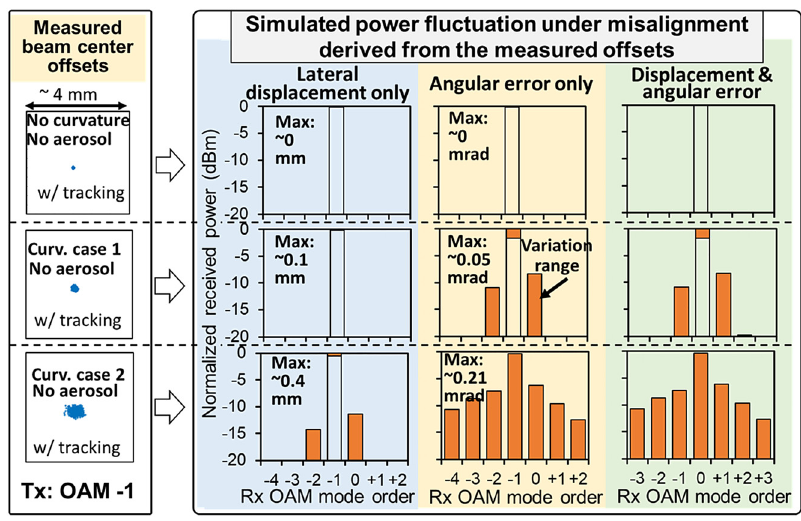
Figure 5: Simulated received power on each mode when OAM − 1 is transmitted under thelateraldisplacement,angularerror,and pointing error (both lateral displacement and angular error). In this simulation, we assume there is only beam misalignment without any other beam distortions. The beam diameter is ∼ 3 mm and the wavelength is 532 nm.